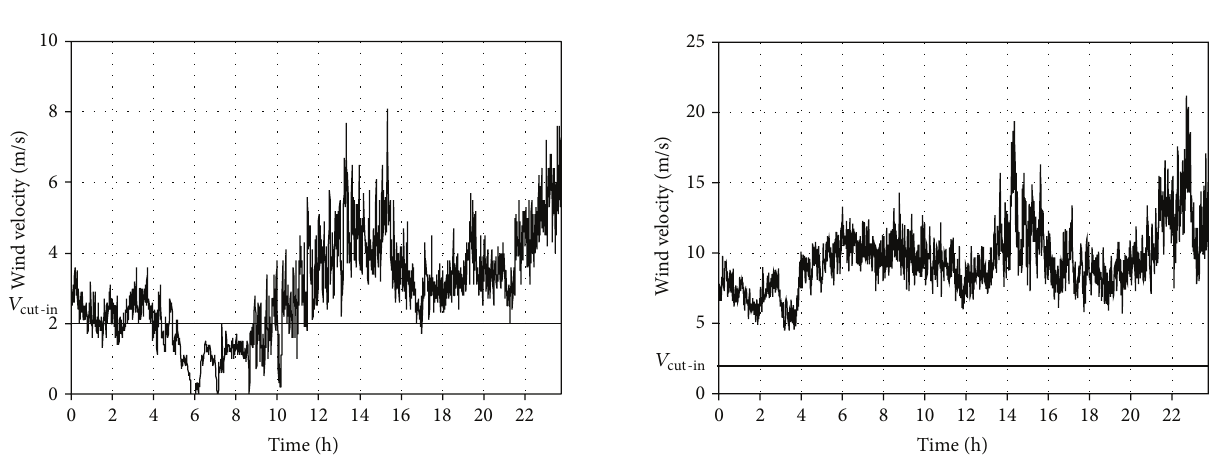
Figure1:Circadianwindvelocitychangesrecordedon1March2008 in Strzy˙z´ow (South Eastern Poland) at the height of ℎ 𝑝 = 10 m above the ground level.